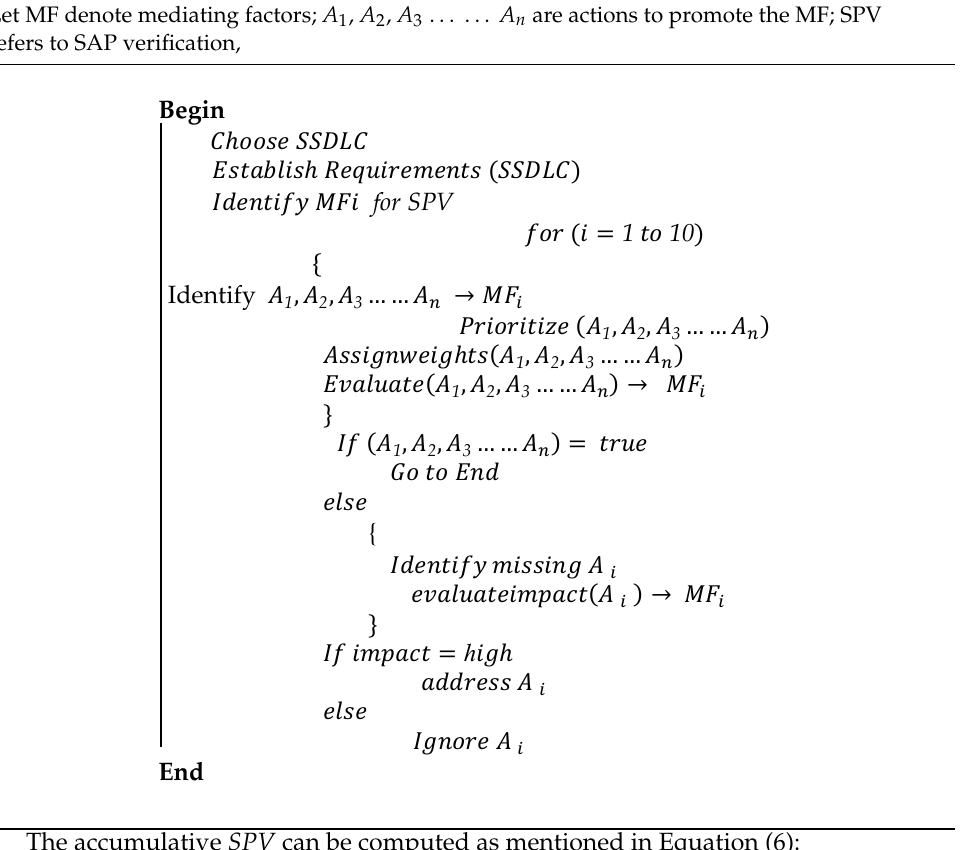
Algorithm 1: Working of the proposed Methodology